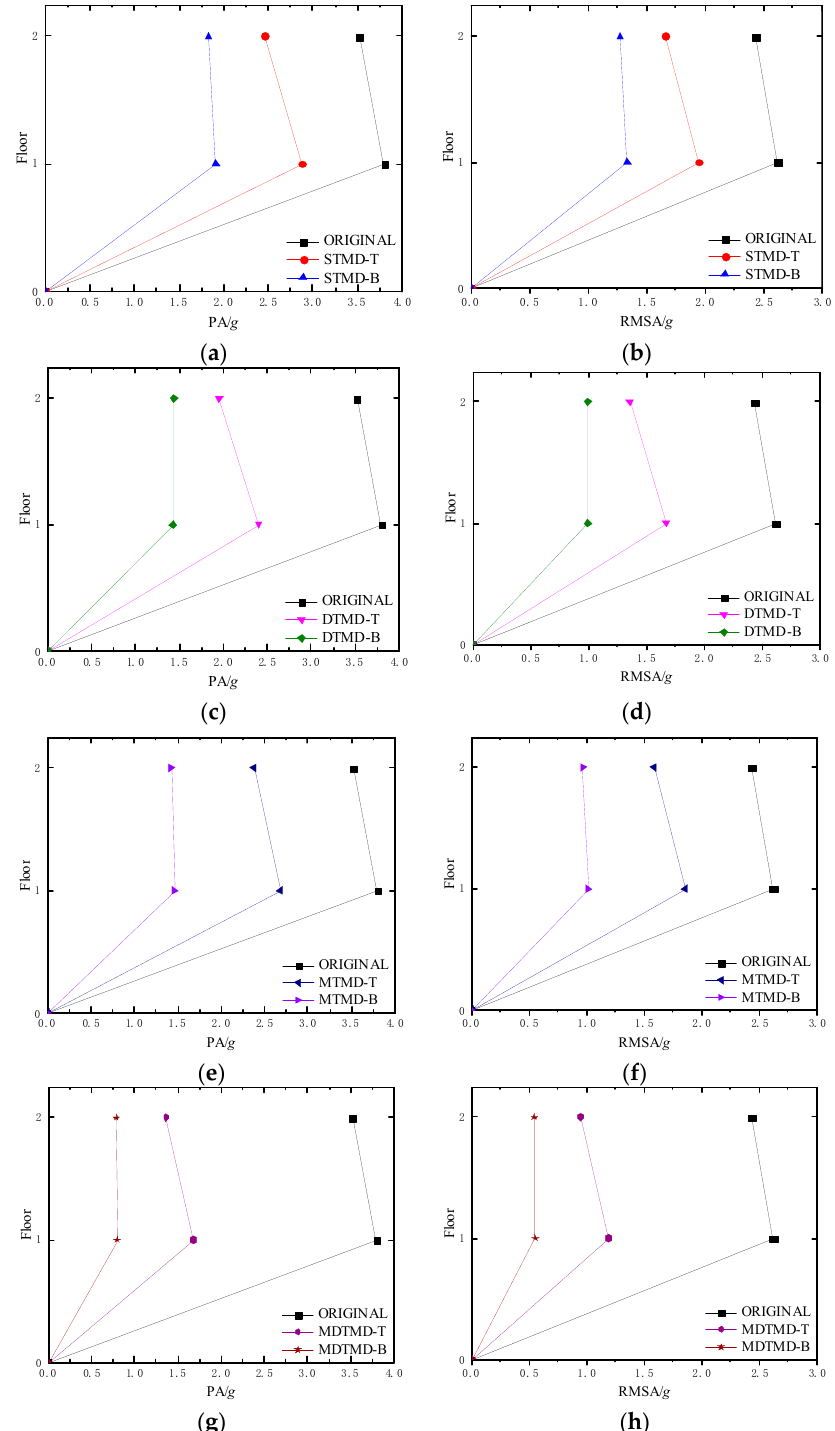
Figure 8. Structural responses of the original structure and vibration-damping structure under simple harmonic excitation various positions: ( a ) STMD peak acceleration; ( b ) STMD RMS acceleration; ( c ) DTMD peak acceleration; ( d ) DTMD RMS acceleration; ( e ) MTMD peak acceleration; ( f ) MTMD RMS acceleration; ( g ) MDTMD peak acceleration; and ( h ) MDTMD RMS acceleration.